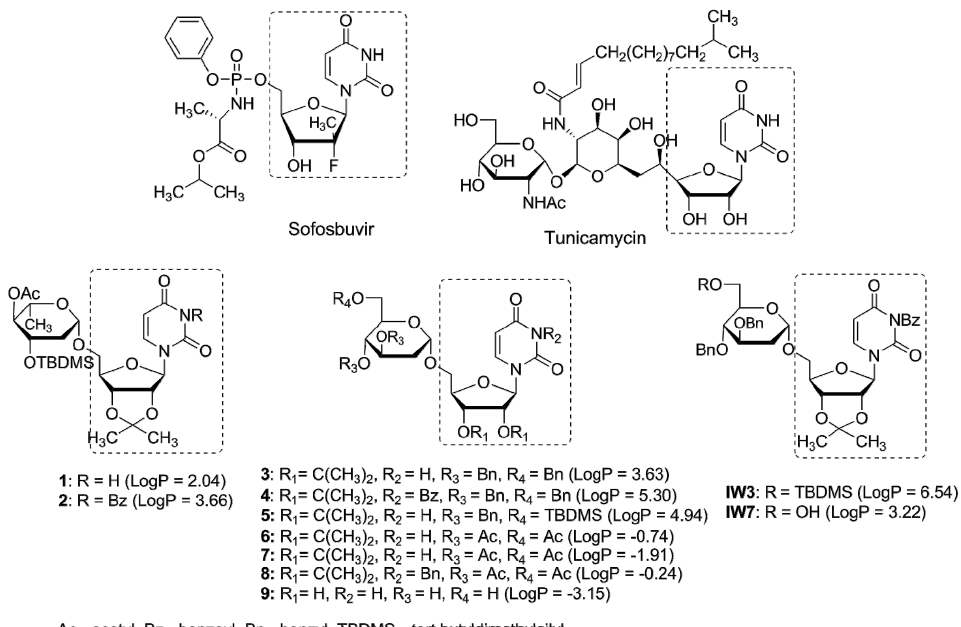
Figure 1. Nucleotide antiviral agents sofosbuvir and tunicamycin and uridine derivatives of 2 ‐ deoxy sugars: 1 – 9 , IW3 , IW7 . LogP values calculated with the XLogP3 algorithm [27] are presented in brackets.